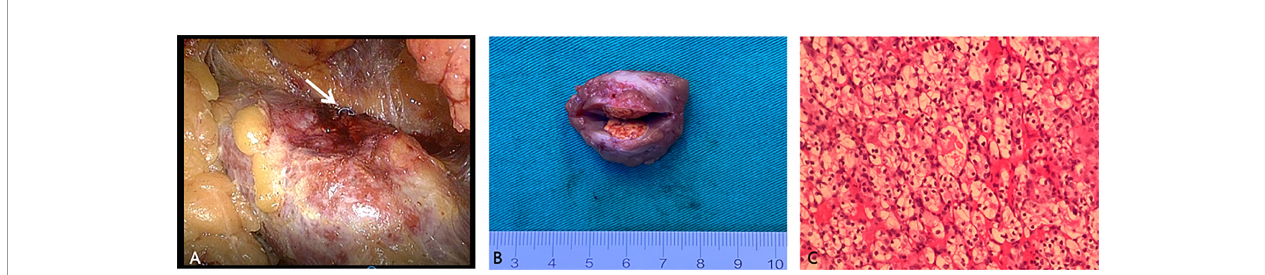
FIGURE 2 | Representative images showing the main steps in video-assisted laparoscopy surgery for the resection of small, totally endophytic renal mass localized preoperatively with the microcoil. (A) The microcoil tail (white arrow) was visualized during laparoscopy. (B) The excised specimen after partial nephrectomy showed an intact tumour with a clear margin. (C) Microscopic sections of the mass showed large polygonal cells with clear cytoplasm and centrally placed small nuclei, indicating renal clear cell carcinoma (haematoxylin-eosin, original magni fi